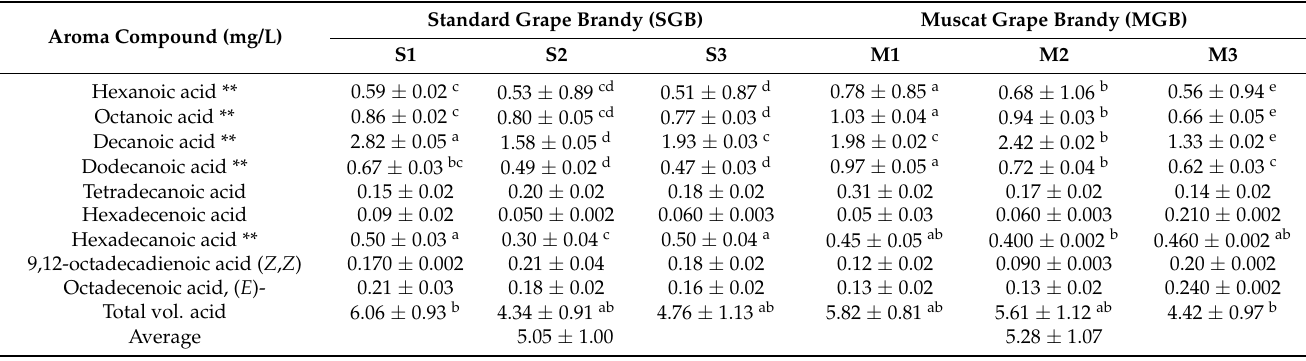
Table 4. Concentration of volatile acids in standard and Muscat grape brandies in mg/L